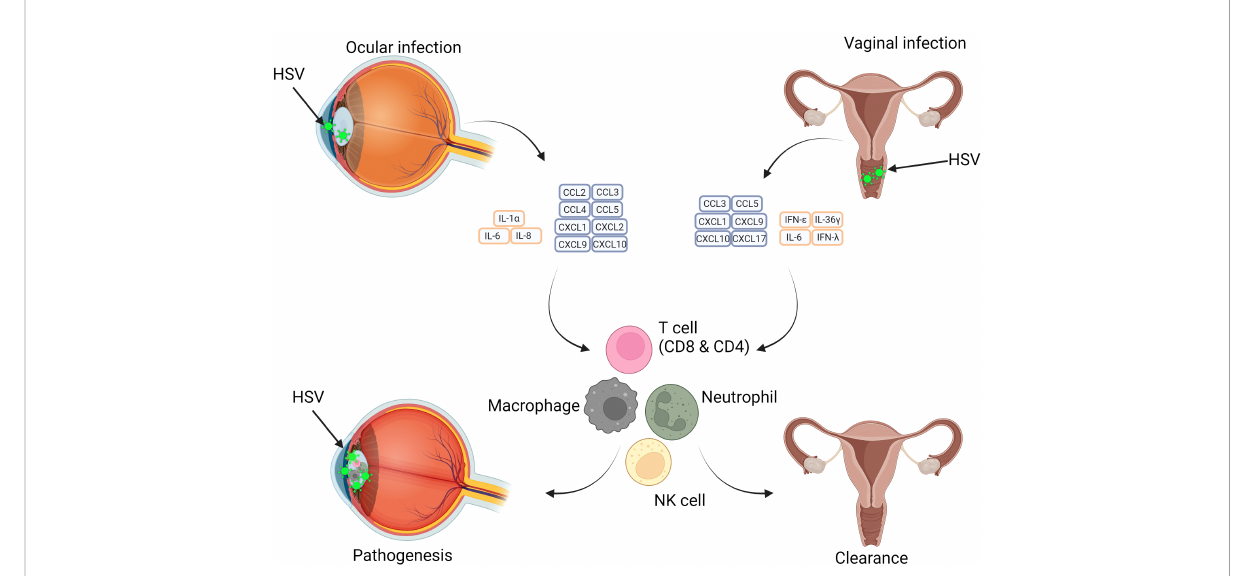
FIGURE 5 Differences in HSV infection of the Eye and Vagina in relation to immunopathology and protective abilities of cytokines and chemokines. HSV infection pathogenesis is site dependent with tissue-speci fi c immune cell responses in fl uencing this. Ocular infection results in a cytokine storm which results in adaptive and innate immune cell recruitment and further damage. In vaginal infection, similar subsets of immune cells are recruited, however the impact is bene fi cial and results in resolution of infection. The varying effects of cytokines impacts the outcome at different anatomical